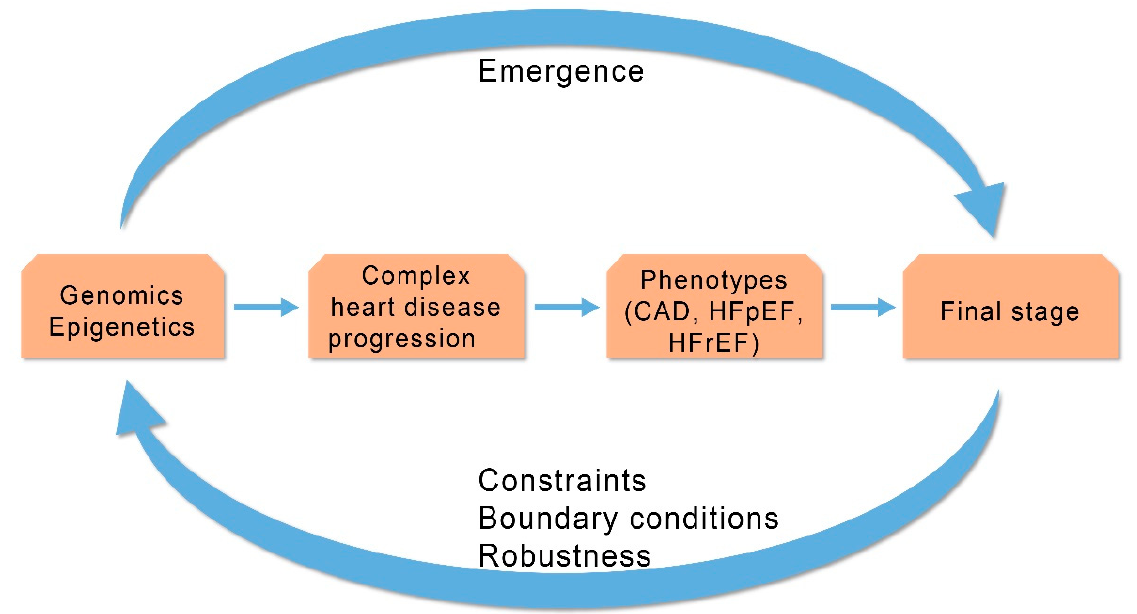
Figure 3. Progression of complex heart diseases: Relationship between emergent properties and constraints outlines progression of complex heart diseases. CAD (Coronary Artery Disease), HFpEF (Heart Failure with Preserved Ejection Fraction), HFrEF (Heart Failure with Reduced Ejection Fraction). (Revised from: [5]).